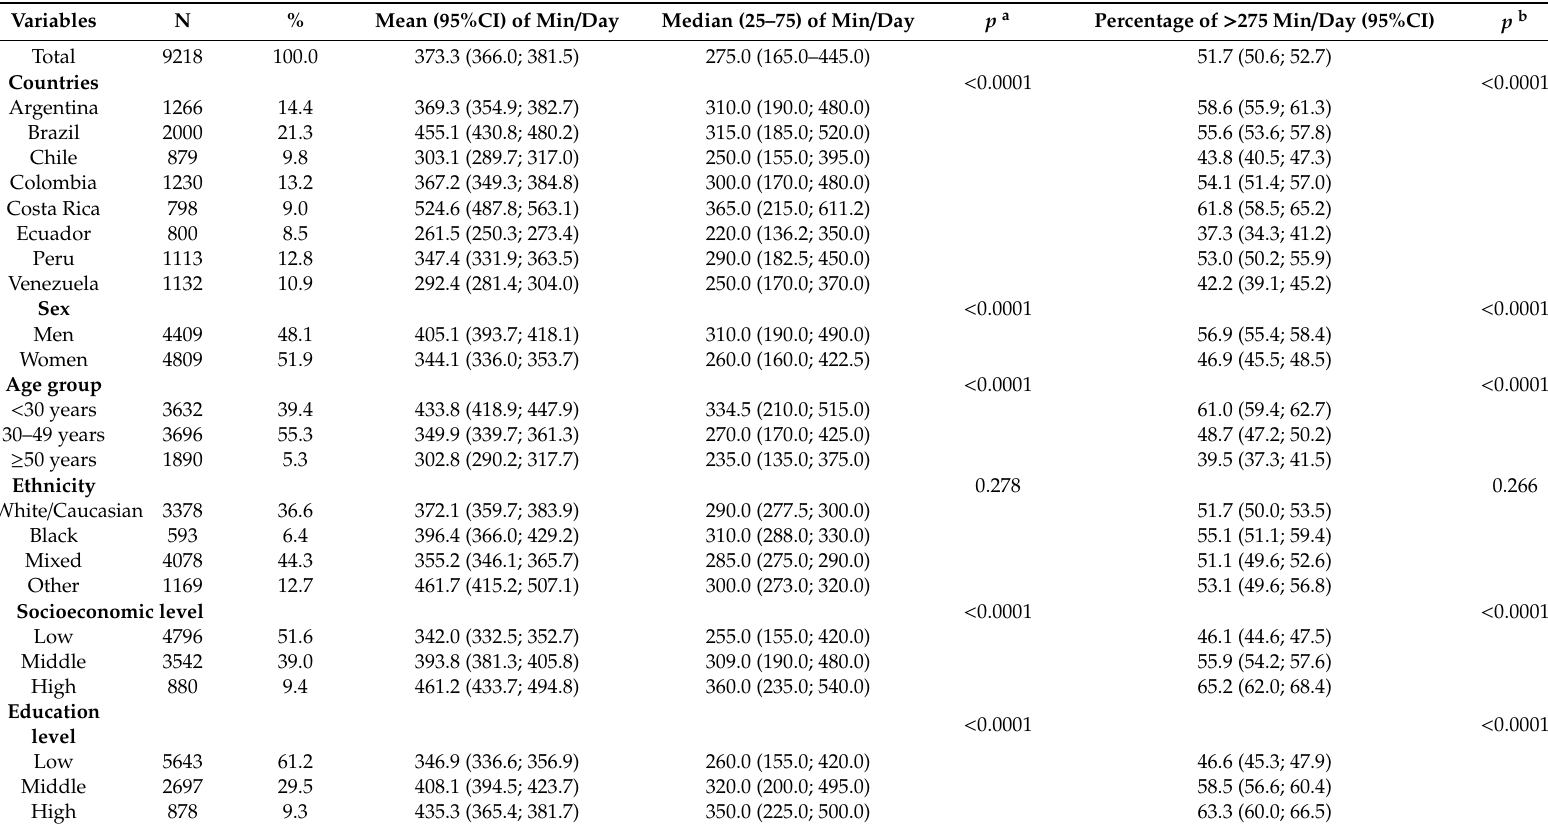
a Mann-Whitney or kruskal-Wallis test for the comparison of medians; b chi-square for